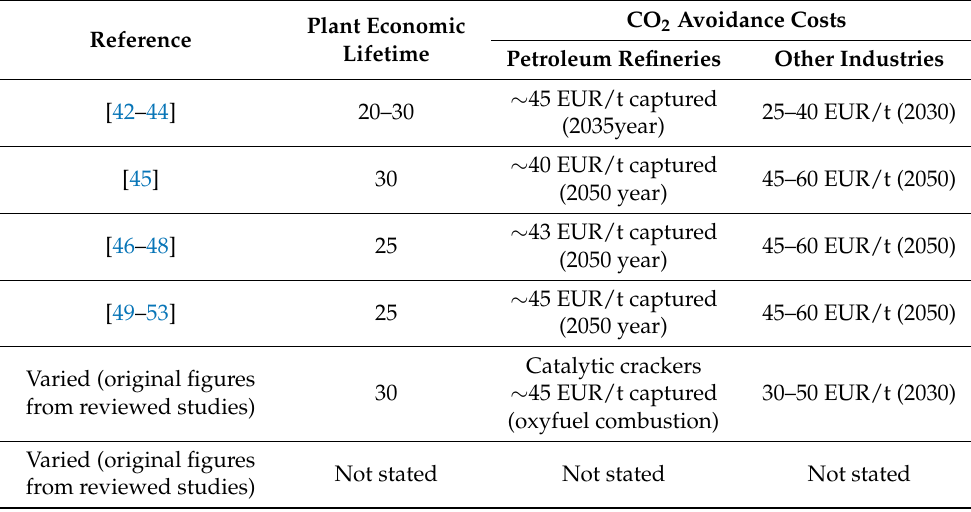
Table 1. Review of major publications analyzing CO 2 capture